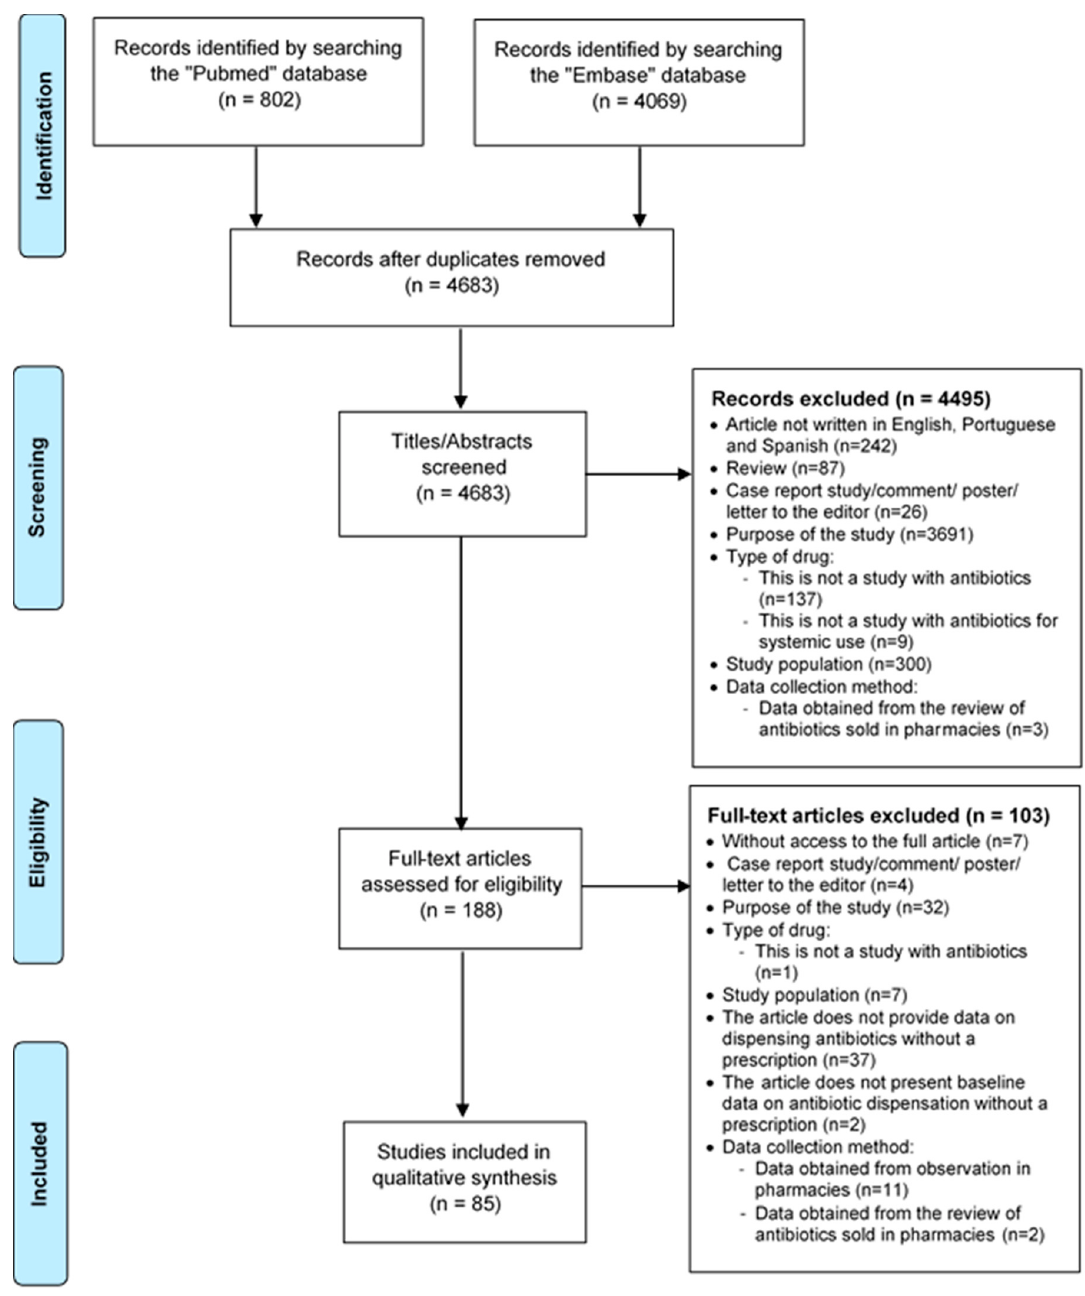
Figure 1. Study selection flowchart.